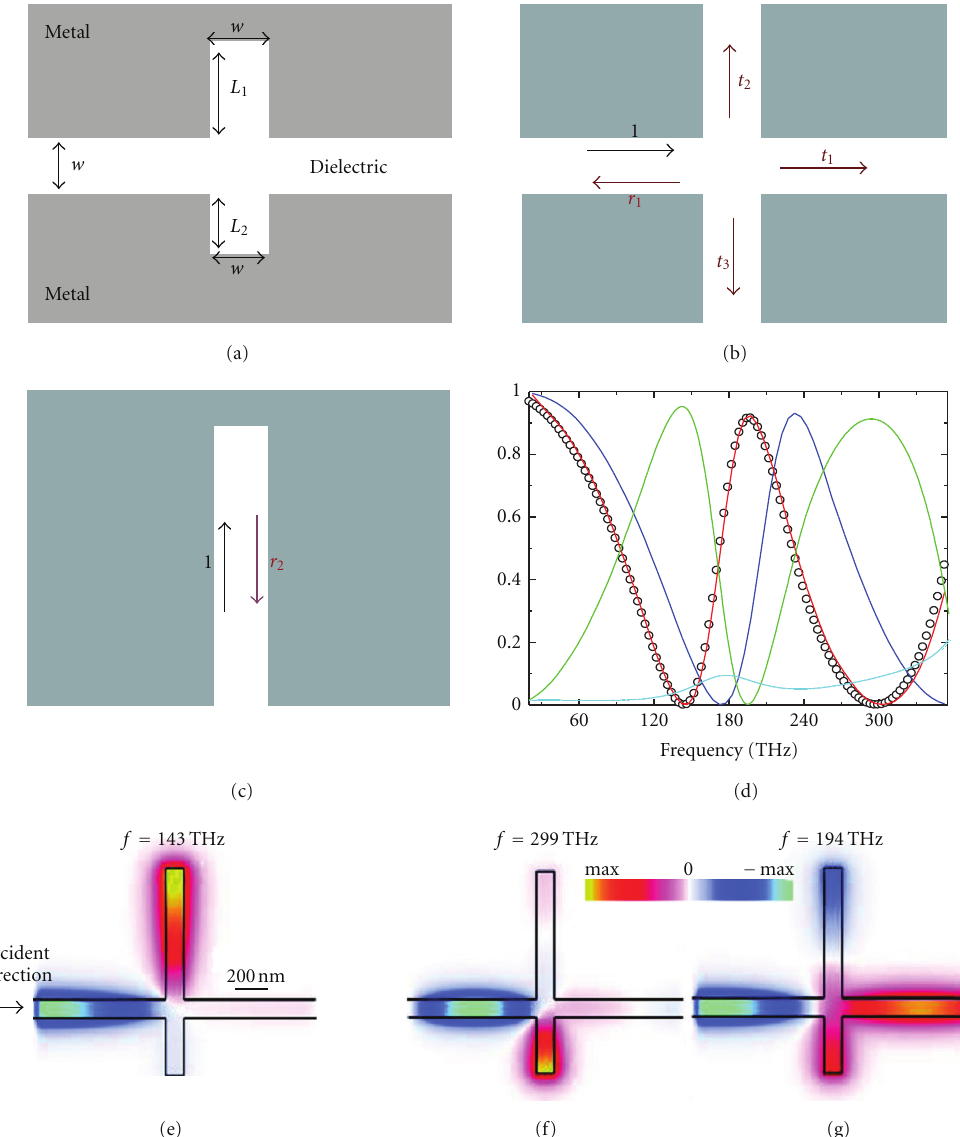
Figure 1: (a) Schematic of a MDM plasmonic waveguide side-coupled to two MDM stub resonators. (b) Schematic defining the reflection coe ffi cient r 1 and transmission coe ffi cients t 1 , t 2 , t 3 when the fundamental TM mode of the MDM waveguide is incident at a waveguide crossing. Note that t 2 = t 3 due to symmetry. (c) Schematic defining the reflection coe ffi cient r 2 of the fundamental TM mode of the MDM waveguide at the boundary of a short-circuited MDM waveguide. (d) Transmission spectra for the structure of (a) calculated using FDFD (circles), transmission line theory (solid blue line), and scattering matrix theory (solid red line) for a silver-air structure with w = 50 nm. Also shown are the reflection (solid green line) and absorption (solid cyan line) spectra calculated using FDFD. Results are shown for L 1 = 360 nm, L 2 = 160 nm. ((e)–(g)) Magnetic field profiles for the structure of (a) for L 1 = 360 nm, L 2 = 160 nm, w = 50nm at f = 143, 299, 194 THz, when the fundamental TM mode of the MDM waveguide is incident from the